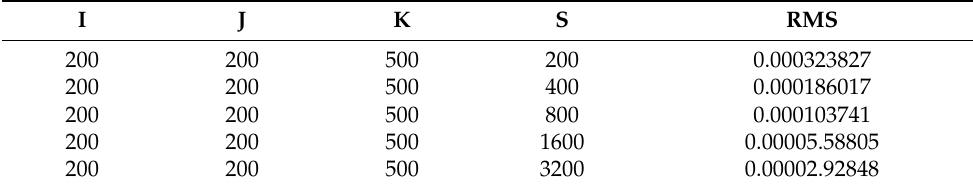
Table 4. Convergence for different mesh sizes along the time